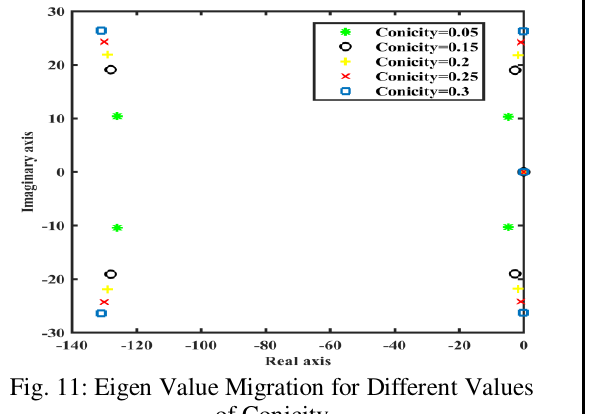
Fig. 11: Eigen Value Migration for Different Values of